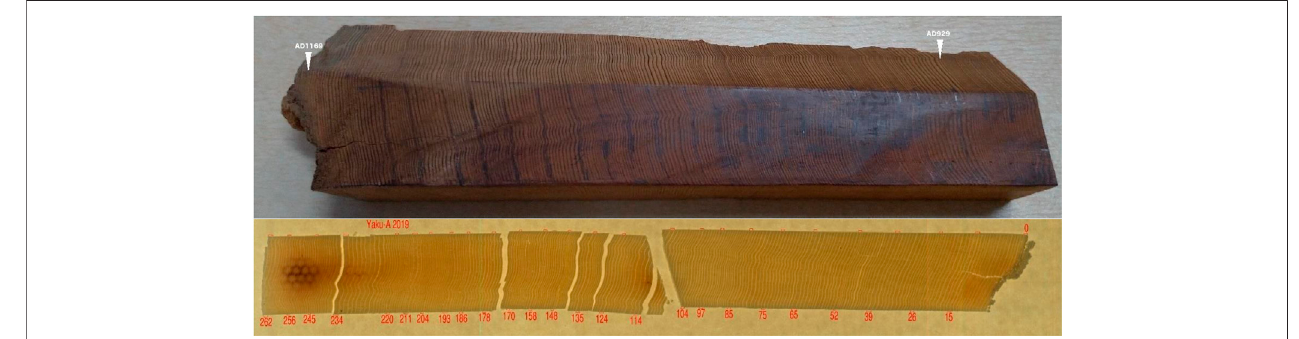
FIGURE 1 | (upper) The Japanese cedar used for this study. (bottom) Plate-shaped cellulose was used for the δ 18 O analysis.